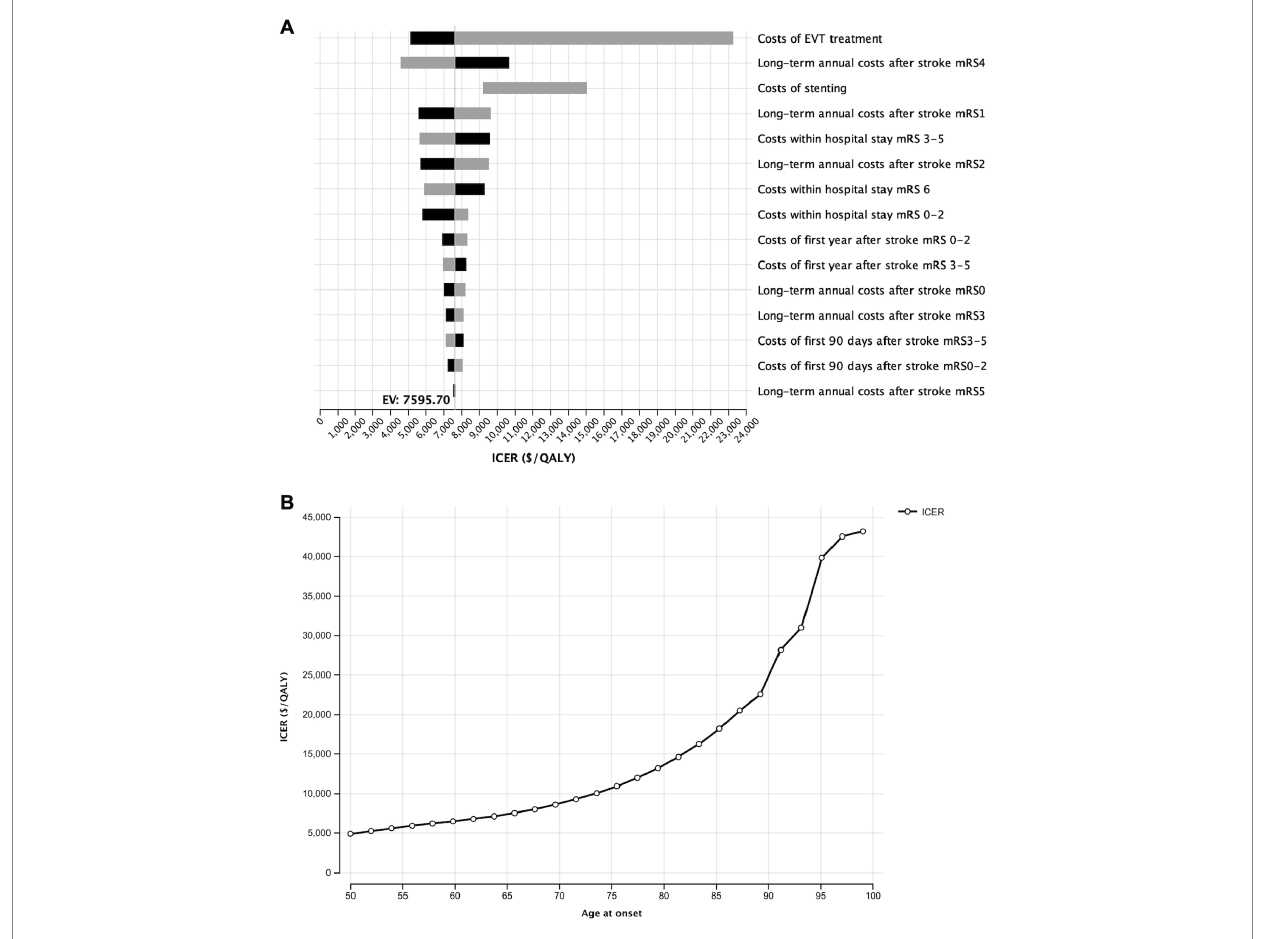
FIGURE 3 Influence of costs variations for the model outcome. (A) Deterministic sensitivity analysis of the impact of all cost variations on the model outcomes upon variation by 25%. (B) One-Way sensitivity analysis of the influence of age at onset on the incremental